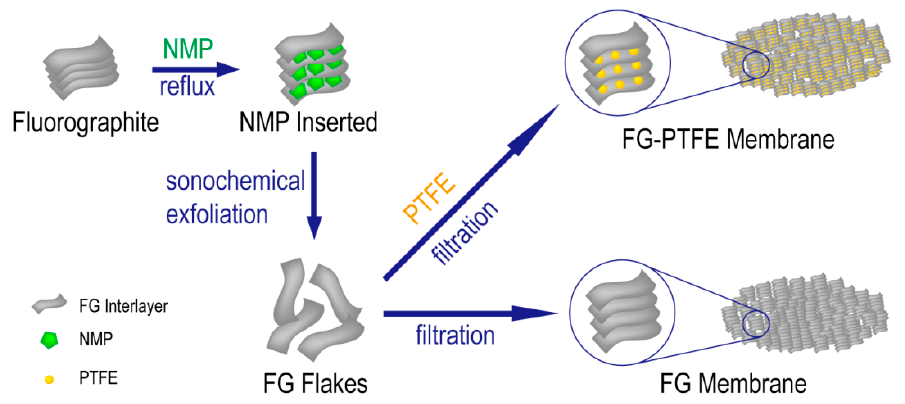
Figure 1. Morphology of fluorographite, FG, and rGO. ( a ) SEM image of fluorographite. ( b ) SEM image of FG flakes. ( c ) SEM image and photograph of an FG membrane. ( d ) SEM cross-sectional image of an FG membrane. ( e ) SEM image and photograph of an rGO membrane. ( f ) SEM cross- sectional image of an rGO membrane.